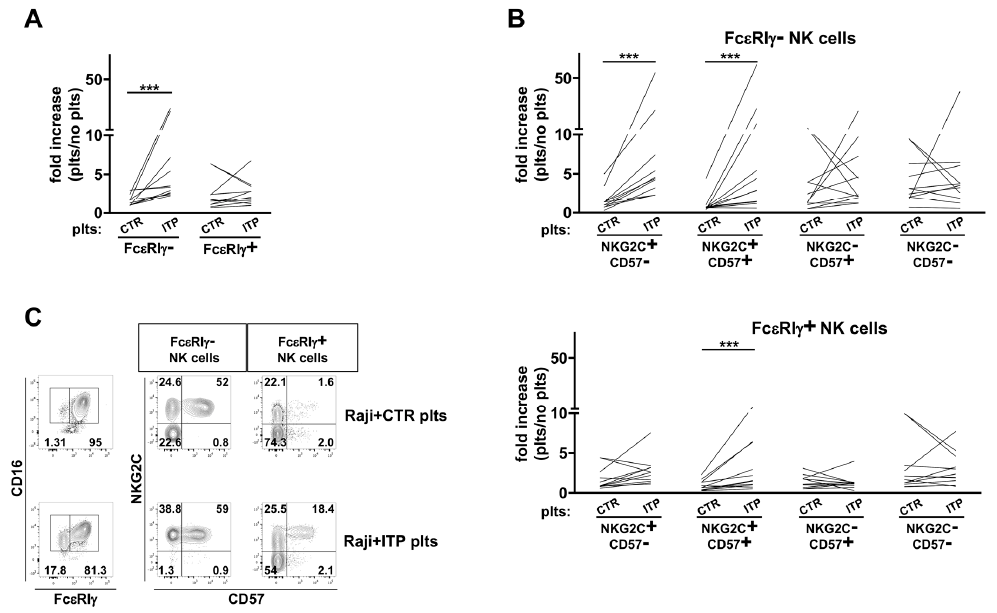
(<0.05): (*) p < 0.05, (**) p < 0.001, (***) p < 0.0001.